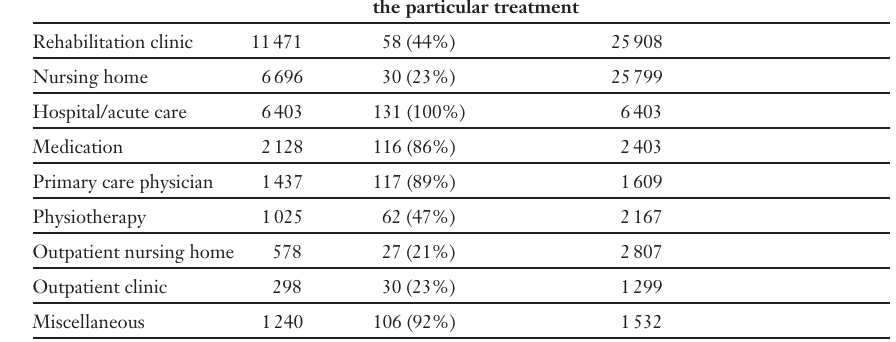
The mean costs per patient are given in detail by two differ- ent modes of calcula- tions: 1. the costs per patient of the total population, and 2. the costs per patient of the sub- group, which in fact obtained the particular treatment.